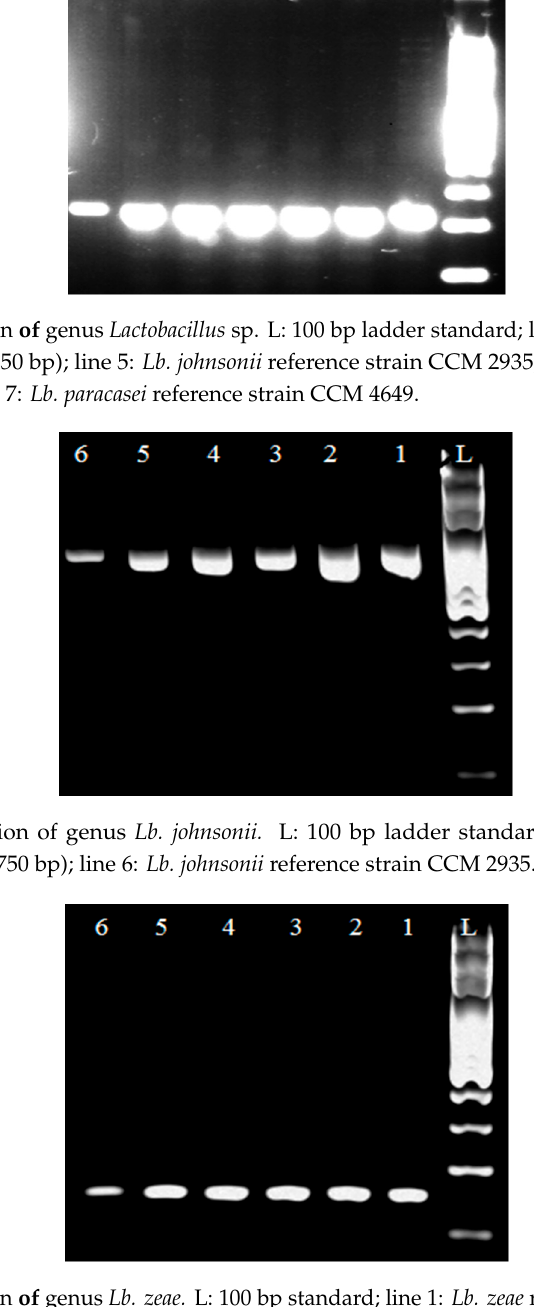
Figure 3. Identification of genus Lb. zeae. L: 100 bp standard; line 1: Lb. zeae reference strain CCM 7069 (750 bp); lines 2, 3, 4, and 5: Lb. zeae isolates .